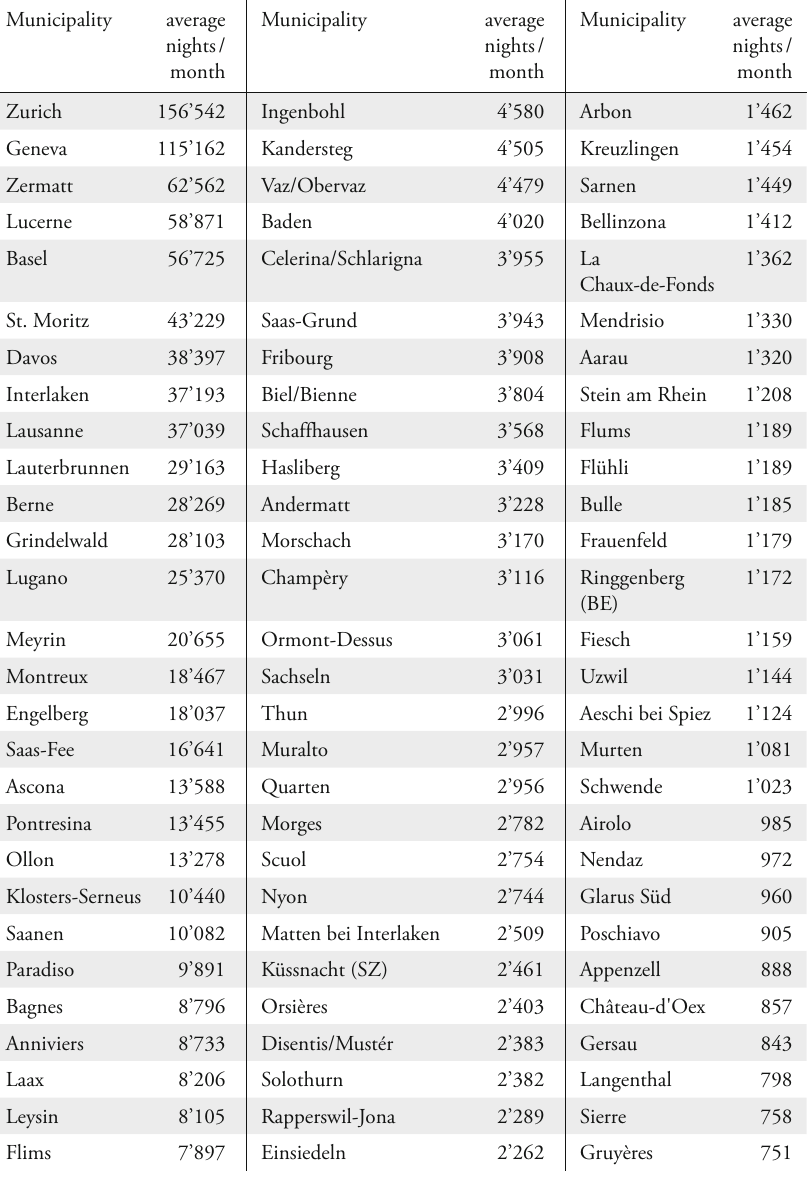
Table 7: Average International Overnight Stays per Month in the 141 Communities